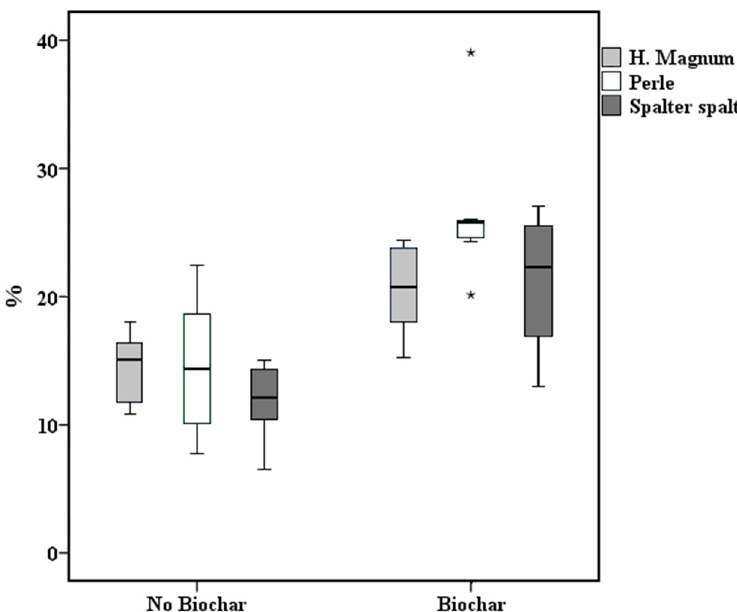
Figure 3. Box plots of root percentages of three different hop cultivars (Hallertau Magnum, Perle and Spalter spalt) and two treatments (presence or absence of biochar). Outliers are displayed as filled stars.